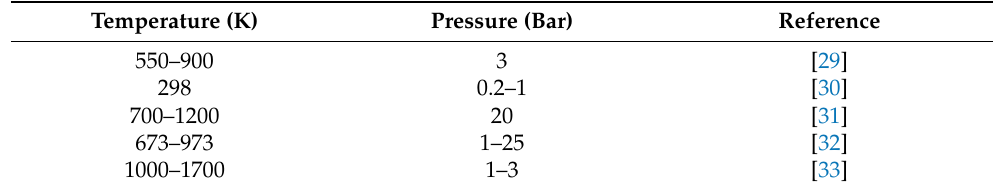
Table 1. Comparison of the ranges for the initial pressure and temperature of kerosene in the literature.